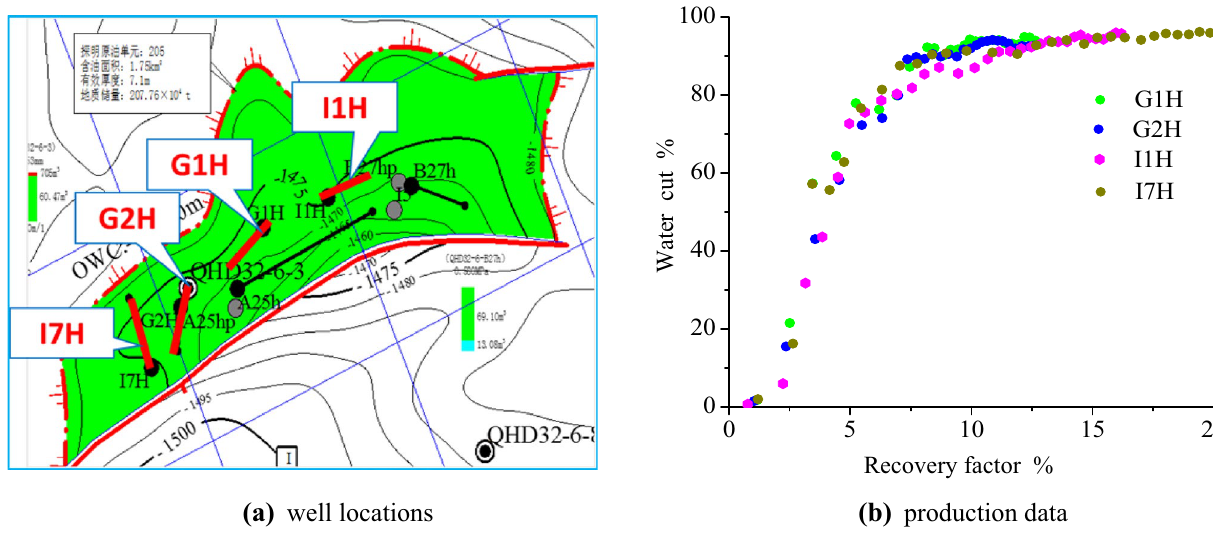
Fig. 4 The well location map and relation curve between water cut and recovery factor Ng1